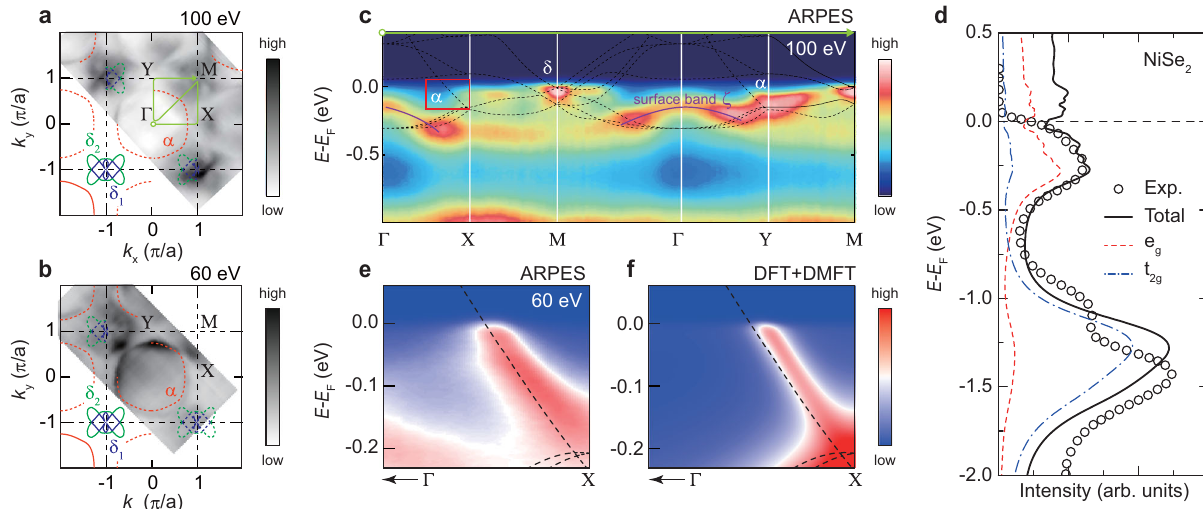
Fig. 1 Electronic structure of NiSe 2 . a , b Fermi surface (FS) maps from ARPES measurement obtained by using 100 and 60 eV photon, respectively. The dashed lines indicate the calculated FS using DFT. c Band structure along the green line in panel ( a ) from ARPES. The dashed lines in c indicate the renormalized DFT band structure. Except for hole-like surface band ζ , complex δ bands near M point and α band dispersion near Y point are well described by the renormalized DFT band structure. d k -integrated spectral function from ARPES and DFT + DMFT calculation. e , f α band near X point from ARPES and DFT + DMFT calculation, respectively. They are from the red boxed region in ( c